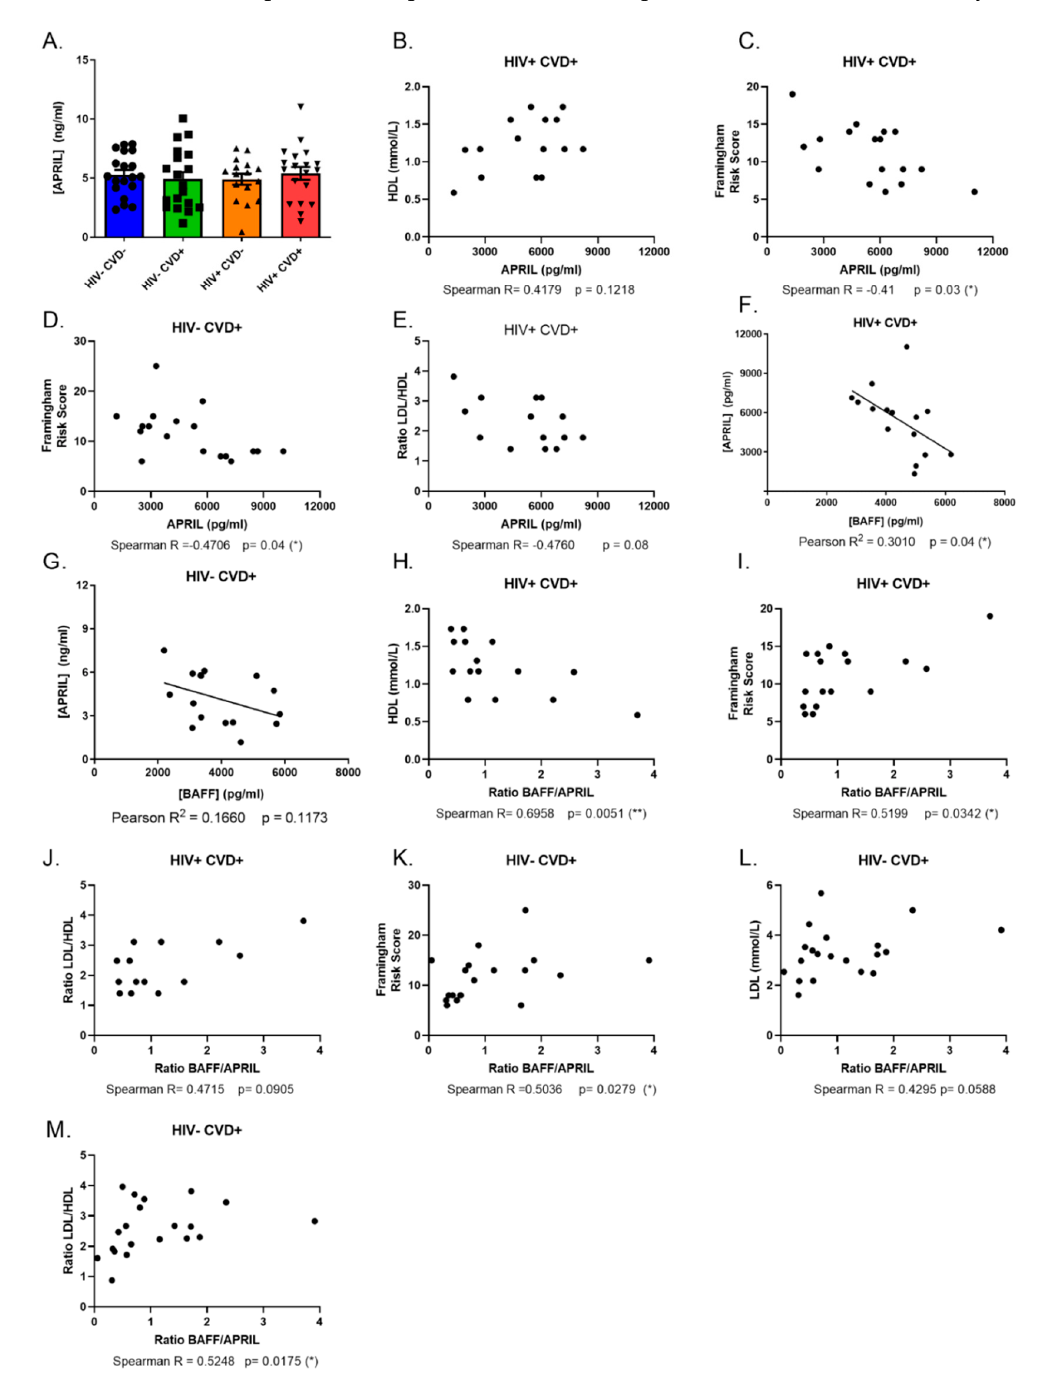
Figure 2. Soluble APRIL levels and correlations between APRIL, BAFF/APRIL ratio and CVD risk factors in the blood of HIV-uninfected (HIV − ) and HIV-infected (HIV+) individuals of the CHACS cohort. Levels of soluble APRIL ( A ) in the blood of HIV-uninfected participants, without and with CVD (HIV − CVD − , HIV − CVD+, respectively), and HIV-infected participants, without and with CVD (HIV+ CVD − , HIV+ CVD+, respectively) selected in sub-cohort ( A ). Correlation between APRIL and HDL levels ( B ), Framingham risk score ( C ) and LDL/HDL ratio ( E ) in HIV+ CVD+ par- ticipants. Correlation between APRIL and Framingham risk score ( D ) in HIV − CVD+ participants. Correlation between BAFF and APRIL in HIV+ CVD+ ( F ) and HIV − CVD+ ( G ) participants. Corre- lation between BAFF/APRIL ratio and HDL ( H ), Framingham risk score ( I ) and LDL/HDL ratio ( J ) in HIV+ CVD+ participants. Correlation between BAFF/APRIL ratio and Framingham risk score ( K ),